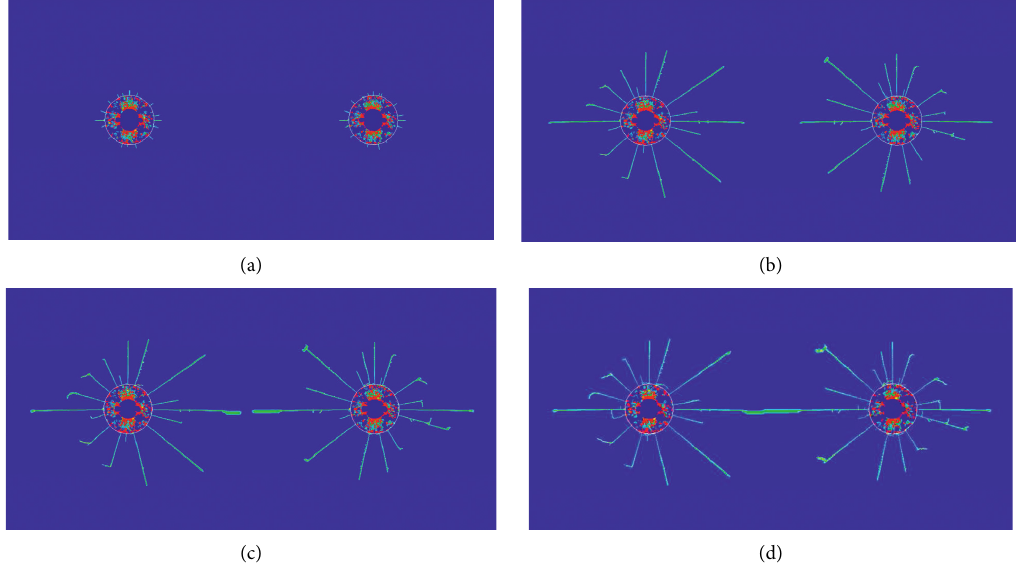
Figure 15: Damage propagation process under double-hole